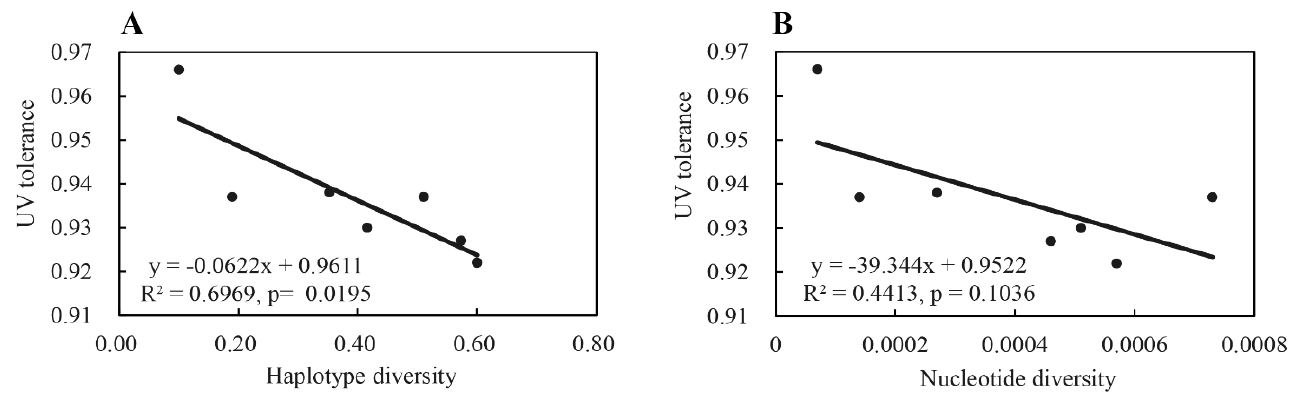
Figure 5. Correlation between UV tolerance and genetic variation (i.e., haplotype and nucleotide diversity) of the RAD23 gene in the seven Phytophthora infestans populations sampled from China: ( A ) haplotype diversity; ( B ) nucleotide diversity.